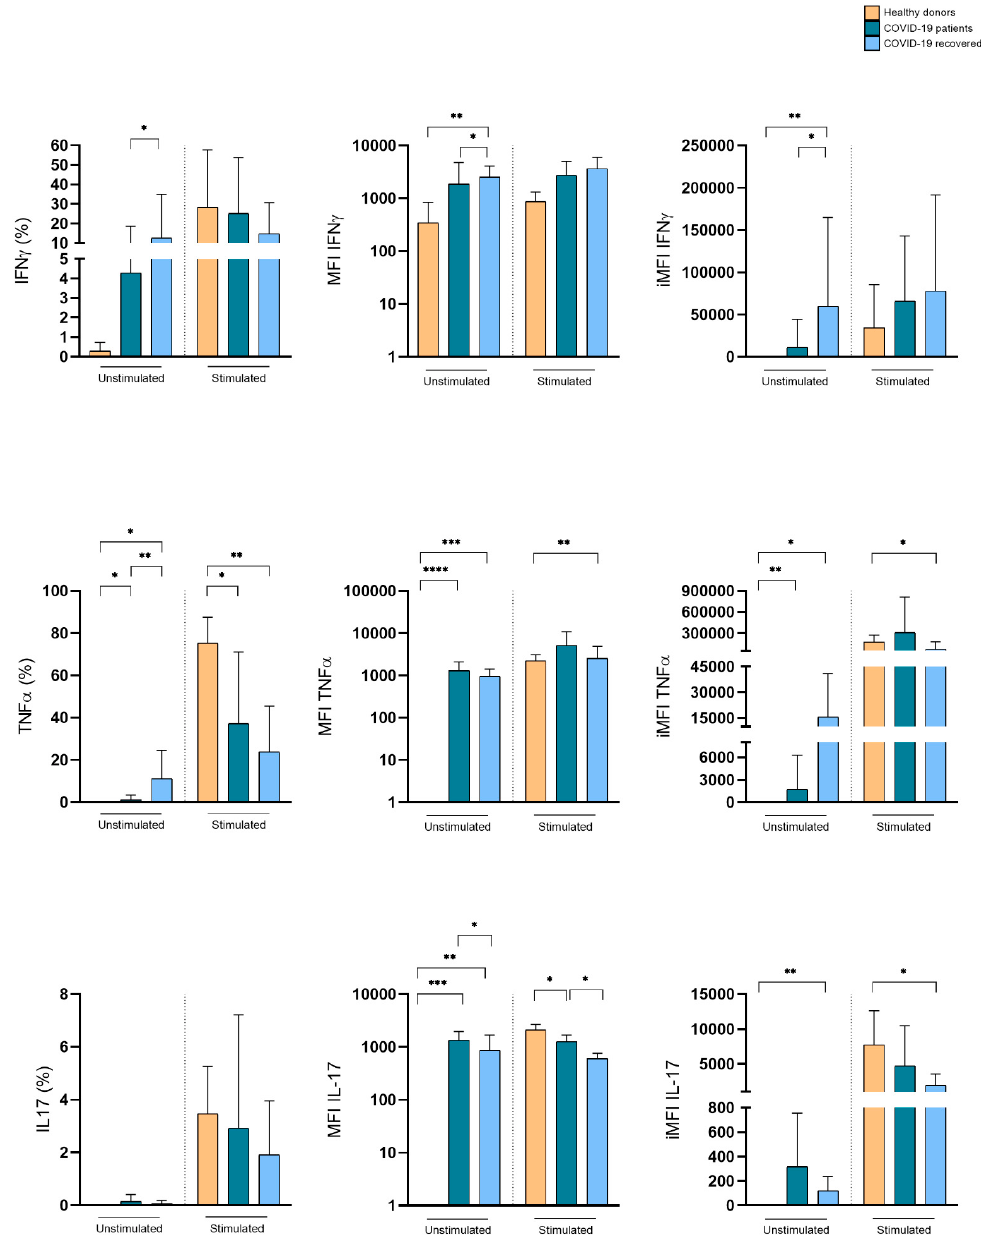
Figure 6. Intracellular cytokine expression by V δ 2+ T lymphocytes in COVID-19 patients and healthy donors upon zoledronate stimulation. Intracellular levels of IFN- γ , TNF- α , and IL-17, in terms of percentage and iMFI, expressed by V δ 2+ T cells, are represented as histogram plots. Shown is mean ± SD. * p < 0.05, ** p < 0.01, *** p < 0.001, and **** p <